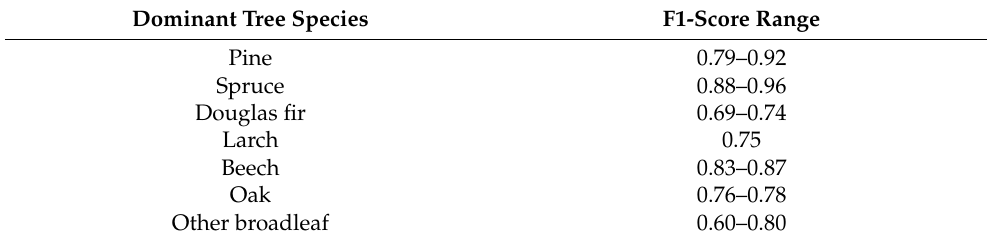
Table 1. F1-score ranges for the different tree species classifications from region-dependent models.